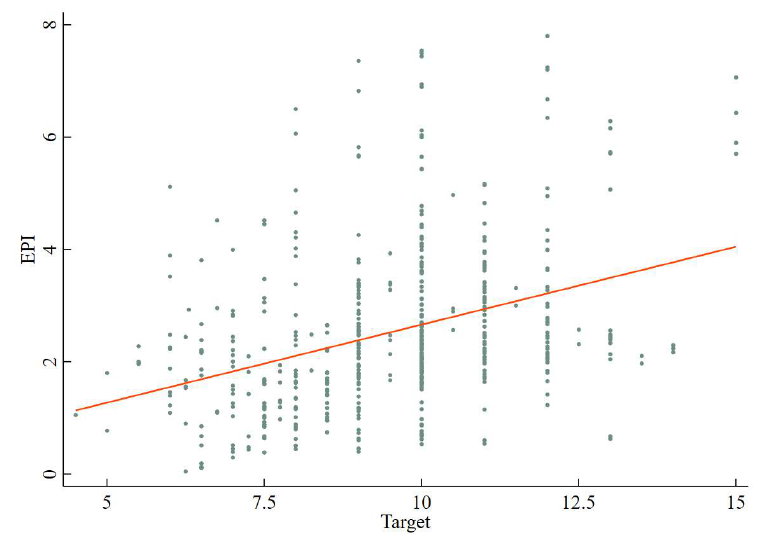
Figure 4. The fitted curve between EGT and EP. Figure 4. The fi(cid:308)ed curve between EGT and EP.